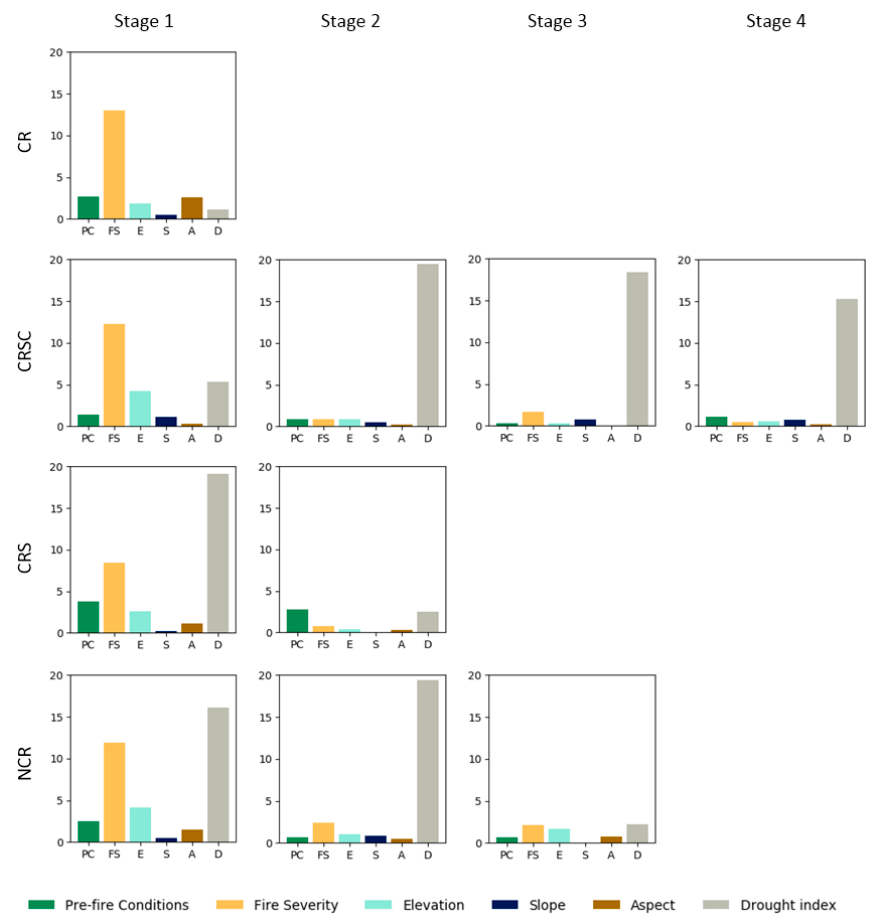
Figure 8. Relative importance of explanatory variables in TCA regression analysis.